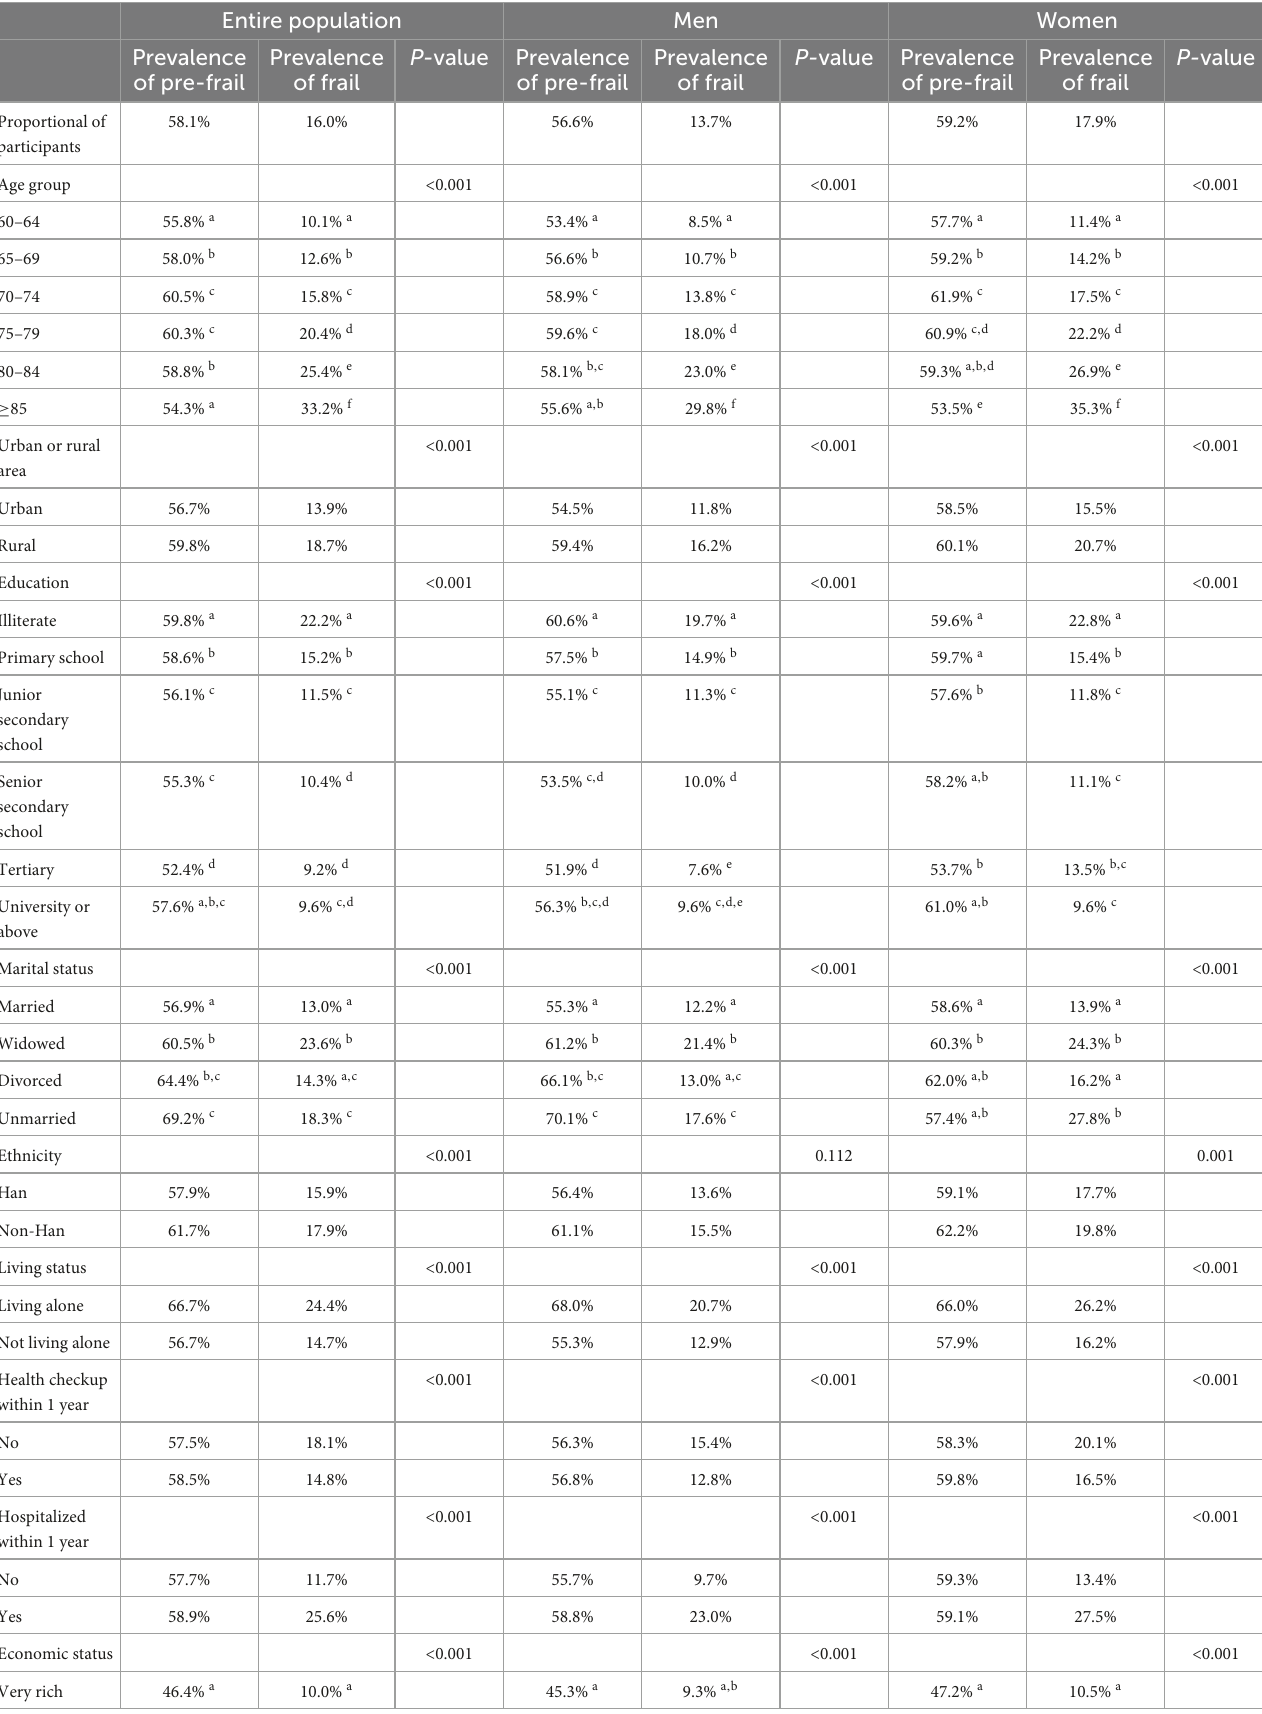
TABLE 2 Prevalence of frailty and pre-frailty among older adults with hypertension in China in 2015. Entire population Men Women Prevalence Prevalence P- value Prevalence Prevalence P- value Prevalence Prevalence P- of pre-frail of frail of pre-frail of frail of pre-frail of frail